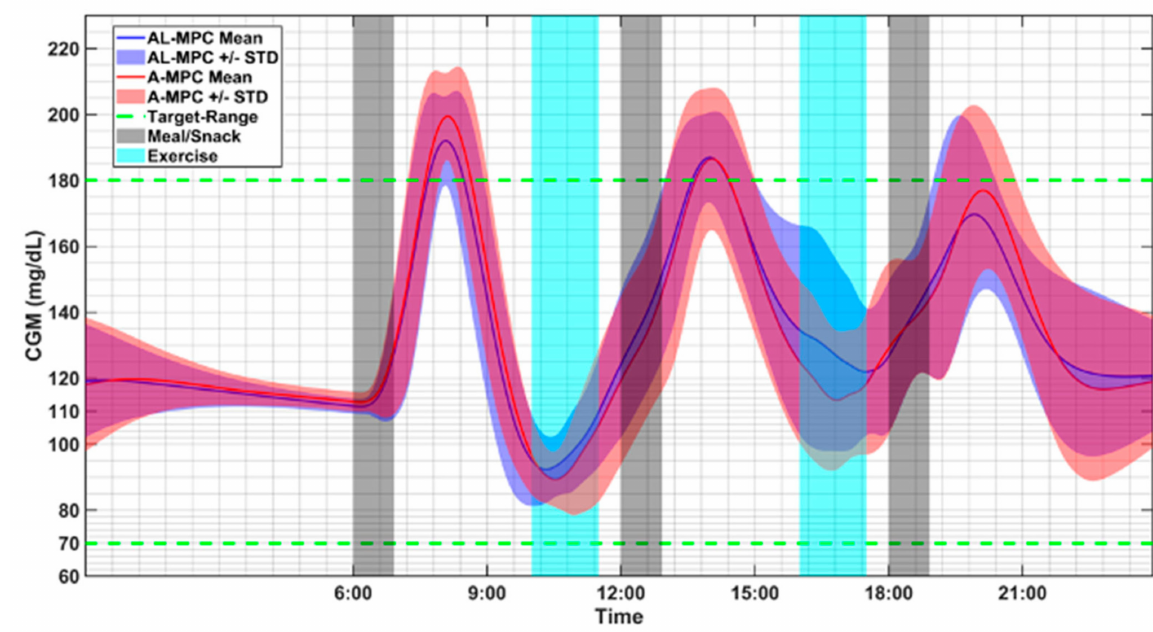
Figure 11. Closed-loop results of mAID for one select subject during whole simulation